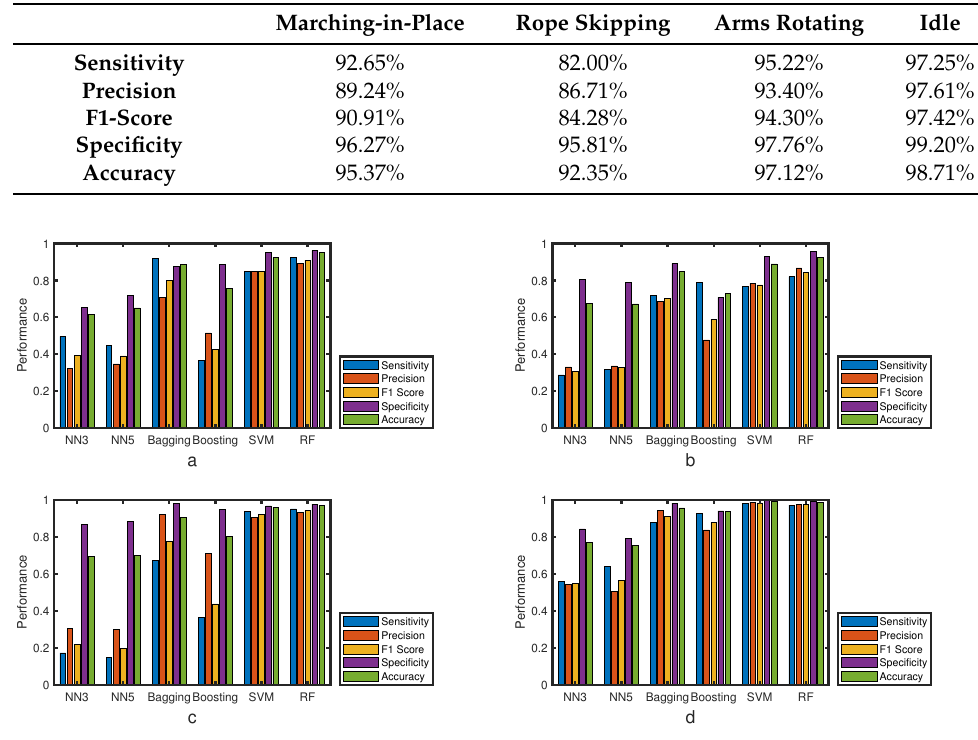
Figure 8. These figures display the sensitivity, precision, F1-score, specificity, and accuracy of ( a ) the marching-in-place exercise, ( b ) rope skipping, ( c ) arms rotating, and ( d ) idle WiFi